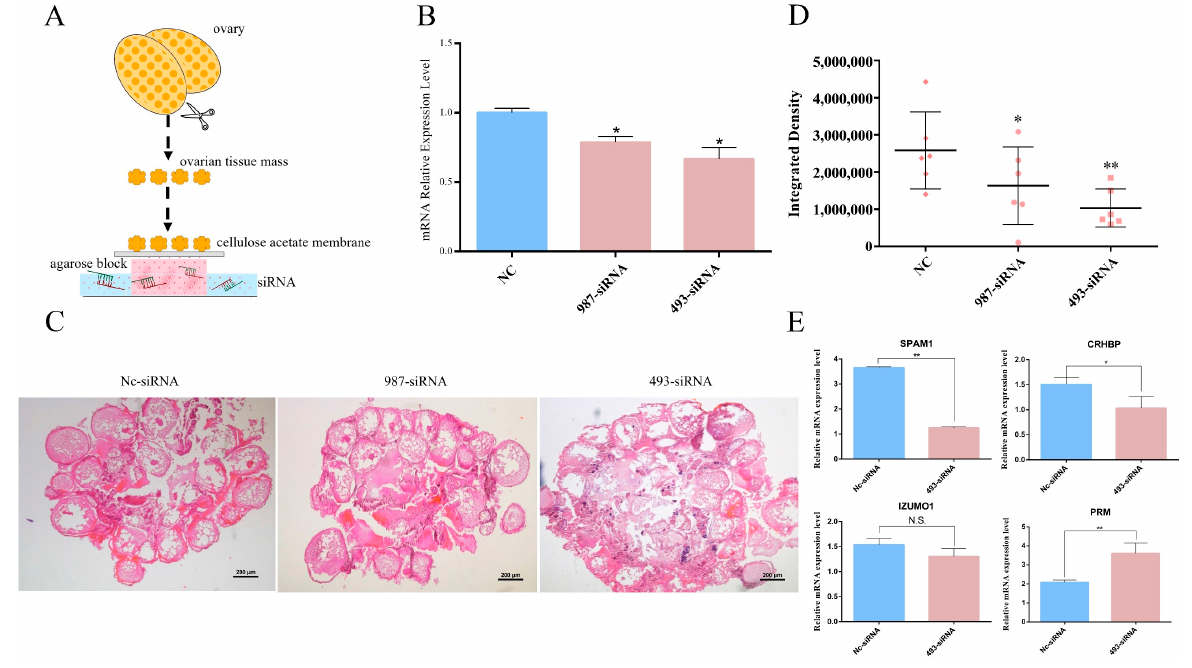
Figure 7. Knockdown of Sszpb2a affected oocyte integrity and interfered with the expression of sperm-associated genes in ovarian blocks cultivated in vitro. ( A ) The model of ovarian tissue mass cultivated on pre-impregnated cellulose acetate film supported by agarose blocks pre-impregnated with medium. ( B ) The silencing efficiency of Sszpb2a treated with different siRNA in ovarian mass. ( C ) Histological observation of ovarian tissue mass at 48 h after siRNA treatment. ( D ) Fluorescence intensity statistics of the ZP layer staining with WGA coupled with rhodamine in different groups of oocytes. WGA: wheat germ agglutinin. ( E ) The expression of sperm-specific genes in ovarian tissue mass treated with 493-siRNA. * p < 0.05, ** p < 0.01, N.S., no significant